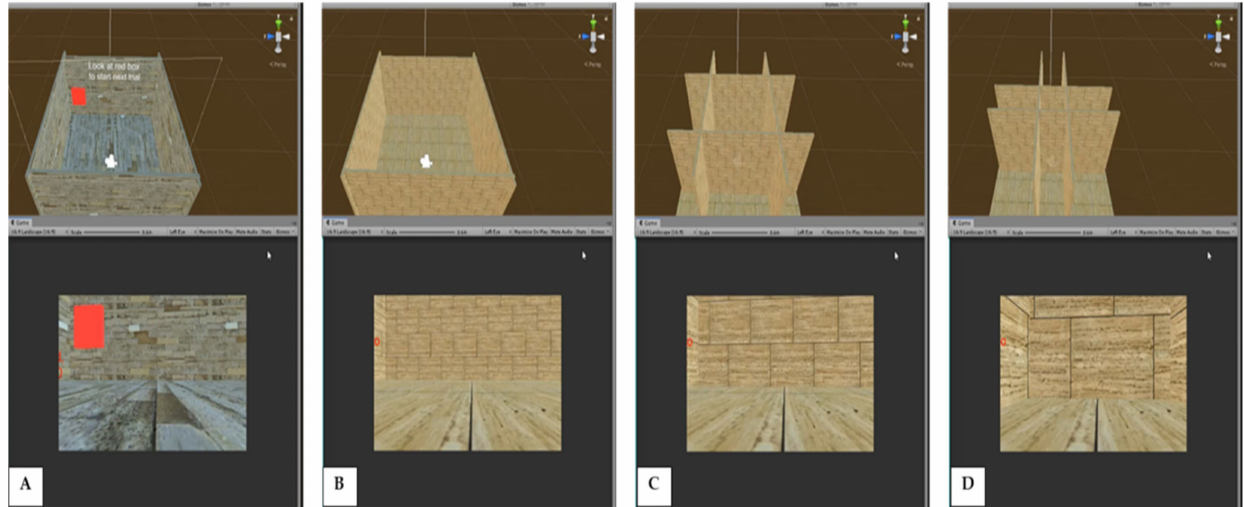
Figure 2. Top level of each figure illustrates the researcher view and bottom level illustrates the participants’ point of view. ( A ) Lobby environment before the start of claustrophobia testing; ( B ) claus- trophobia testing environment, start of the trial; ( C ) mid-point of claustrophobia testing (walls closing in); ( D ) completed claustrophobia testing (walls fully closed